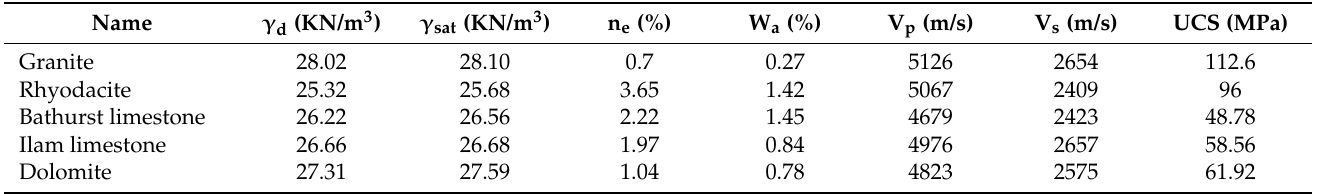
Table 3. Physical and mechanical properties of the